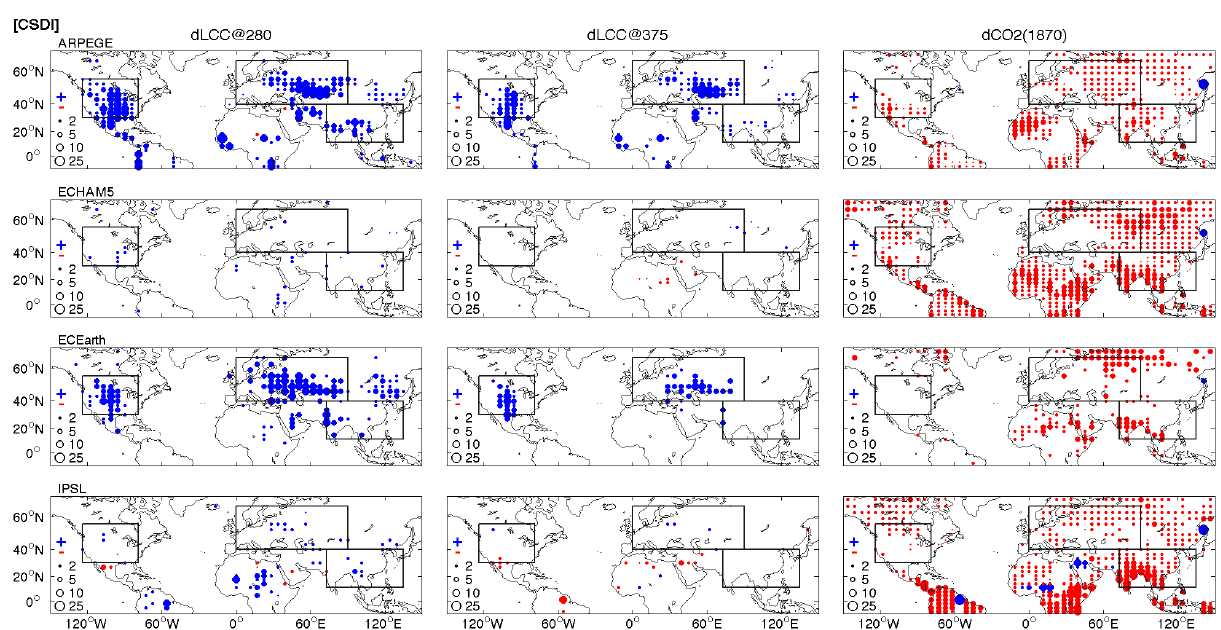
Fig. 8. As Fig. 4 but for the cold spell duration index (CSDI, daysyr − 1 ). Note that for this index, blue indicates an increase in the number of cold days and red indicates a decrease in the number of cold